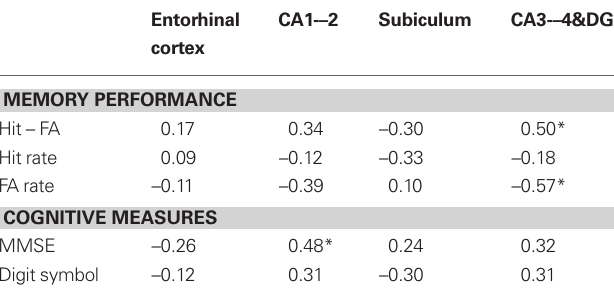
Table 1 | Correlations between HC subfield volumes, memory performance, and cognitive measures in older